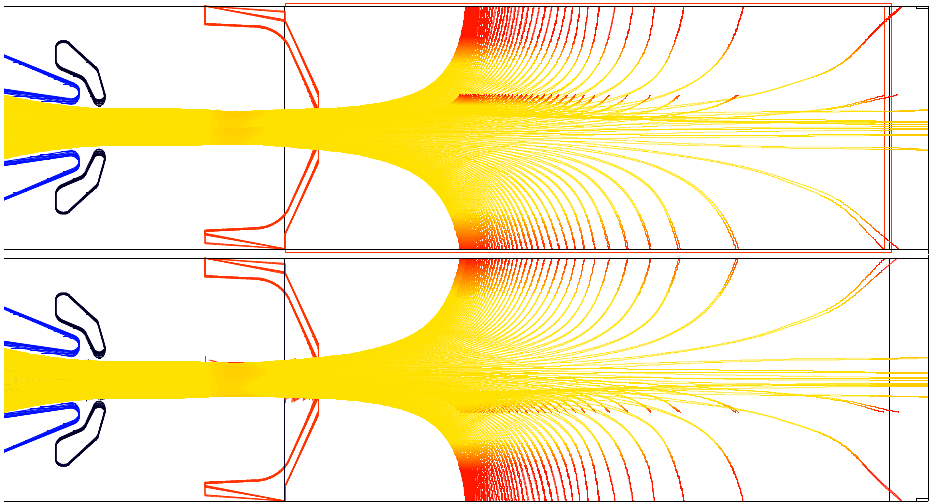
Figure 2. Projection of magnetic field lines crossing the extraction aperture on a radius of 4mm. Top: horizontal, bottom: vertical. The field lines shown originate from one of three radial loss lines, depending on the azimuth. The field lines to the other three radial loss areas go the other (injection) side. Thus it is evident that the full length of the PC must be included in the simulation; this occupies about 70% of the total simulation volume. The plasma electrode (red) is opposite to a negative electrode (black) and a grounded electrode (blue). This kind of system is called an accel–decel extraction